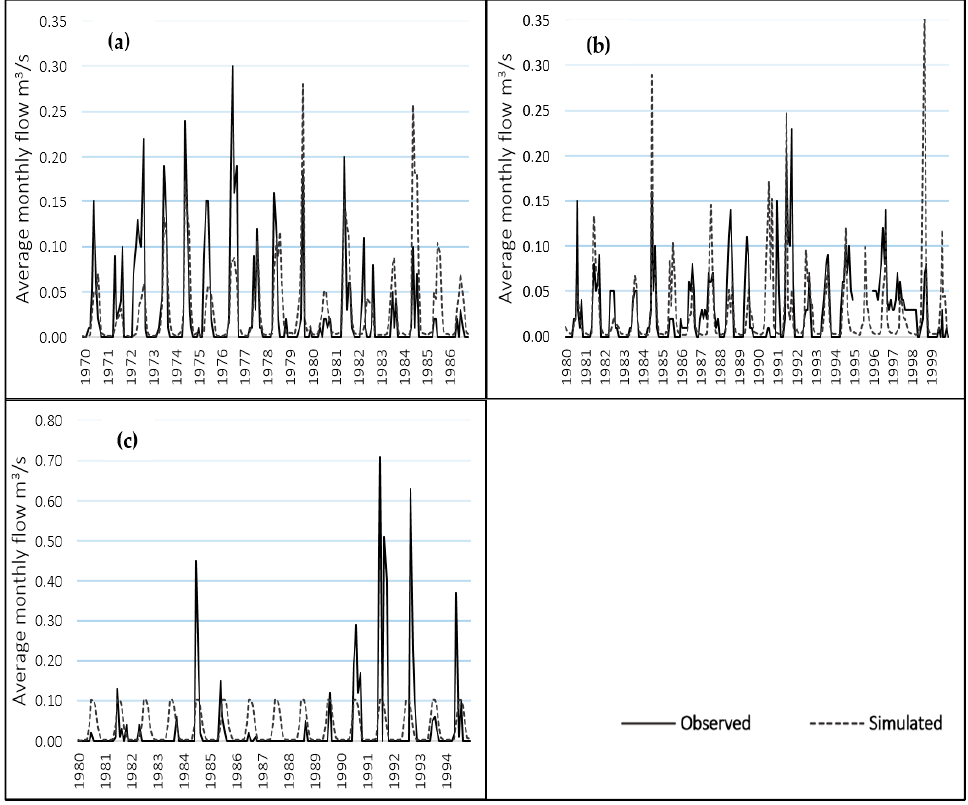
Figure 5. Mean monthly flow rates, simulated and observed: ( a ) Texcoco River, ( b ) Chapingo River, ( c ) San Bernardino River.